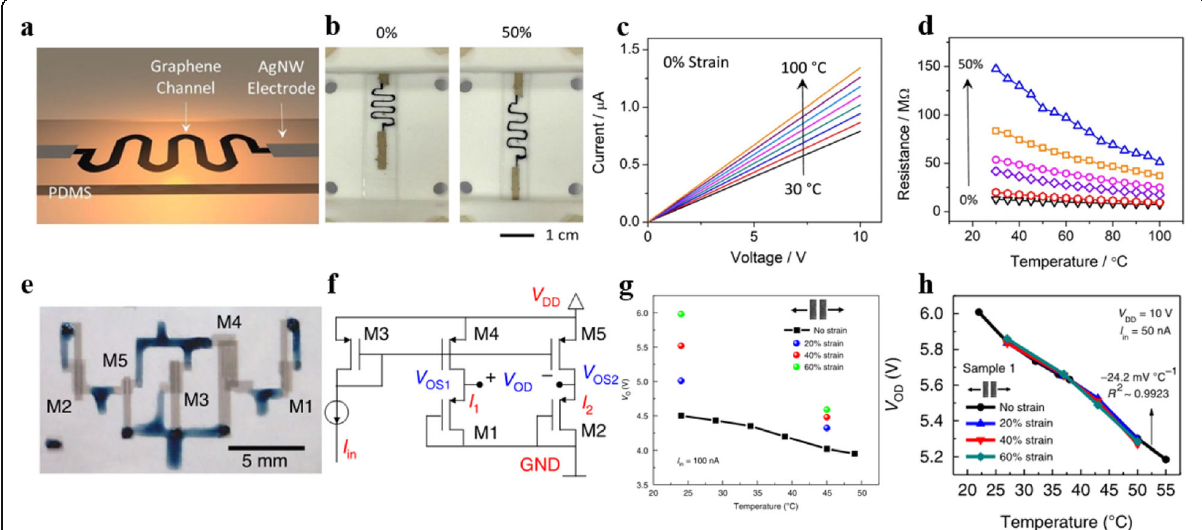
Fig. 8 a Schematic diagram of the stretchable of the graphene thermistors. b Image of the graphene thermistor at 0% and 50% strain. c Resistance variation with temperature. d Resistance variation with temperature within 0 – 50% strains. Adapted with permission from ref.